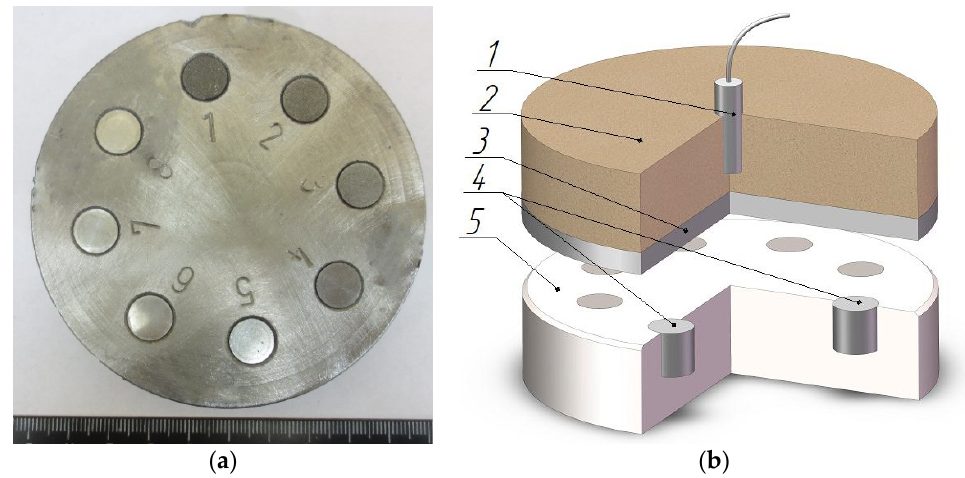
Figure 4. Schematic of shock-wave experiments: ( a ) matrix with specimens, ( b ) schematic of testing under shock-wave loading: (1) detonator, (2) explosive, (3) flyer plate (steel), (4) specimens, (5) matrix.